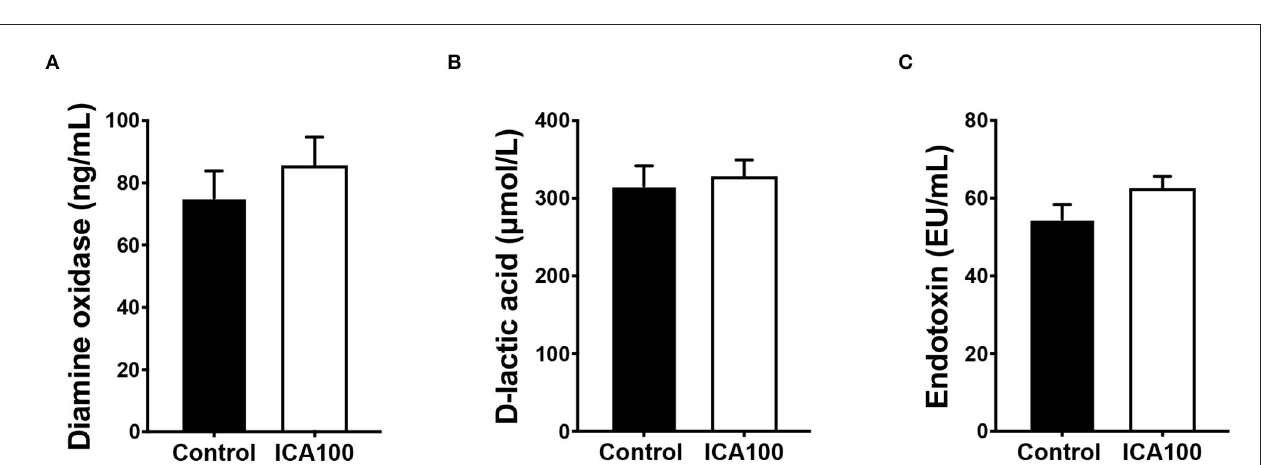
FIGURE 2 | Effects of dietary ICA supplementation on the DAO activity (A) , D-lactic acid concentration (B) , and endotoxin content (C) in serum of weaned piglets. Data are expressed as mean ± SEM. ICA100, the basal diet supplemented with 100 mg/kg indole-3-carboxaldehyde. DAO, diamine oxidase.